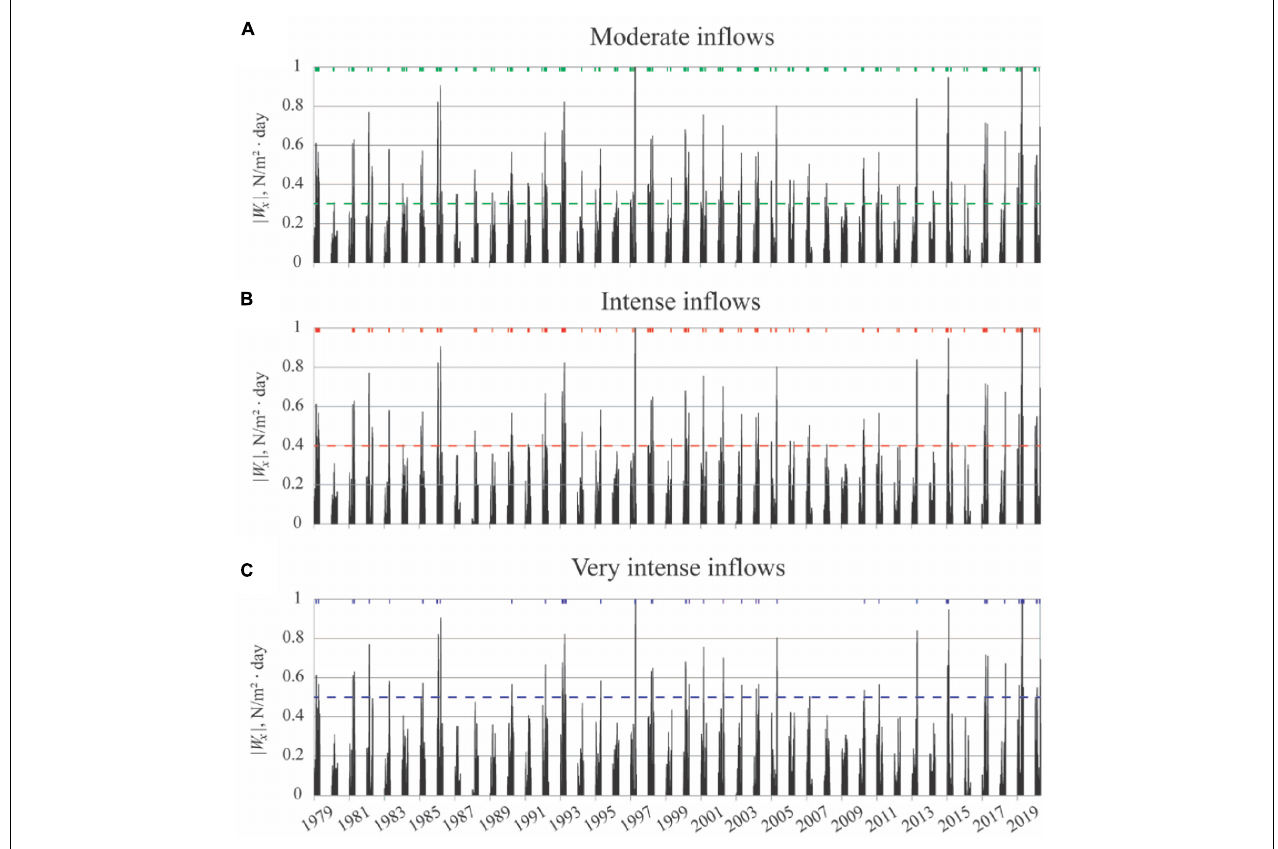
FIGURE 10 | Absolute value of upwelling wind stress integral in the central part of the Kara Sea calculated from the ERA5 atmospheric reanalysis, indicating periods of upwelling-induced moderate inflows (green bars) (A) , intense inflows (red bars) (B) , and very intense inflows (blue bars) (C) to the Gulf of Ob during ice-free seasons (July to October) in 1979–2020. Note that these estimations are based on wind data and not based on in situ